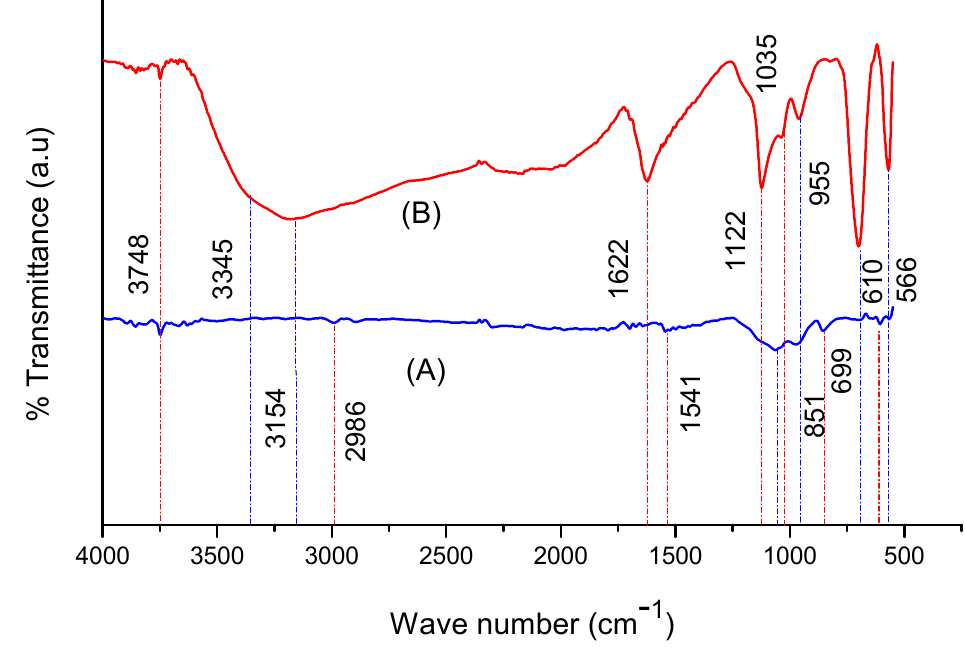
Figure 2. FTIR spectra of (A) welding wastes and (B) GO.